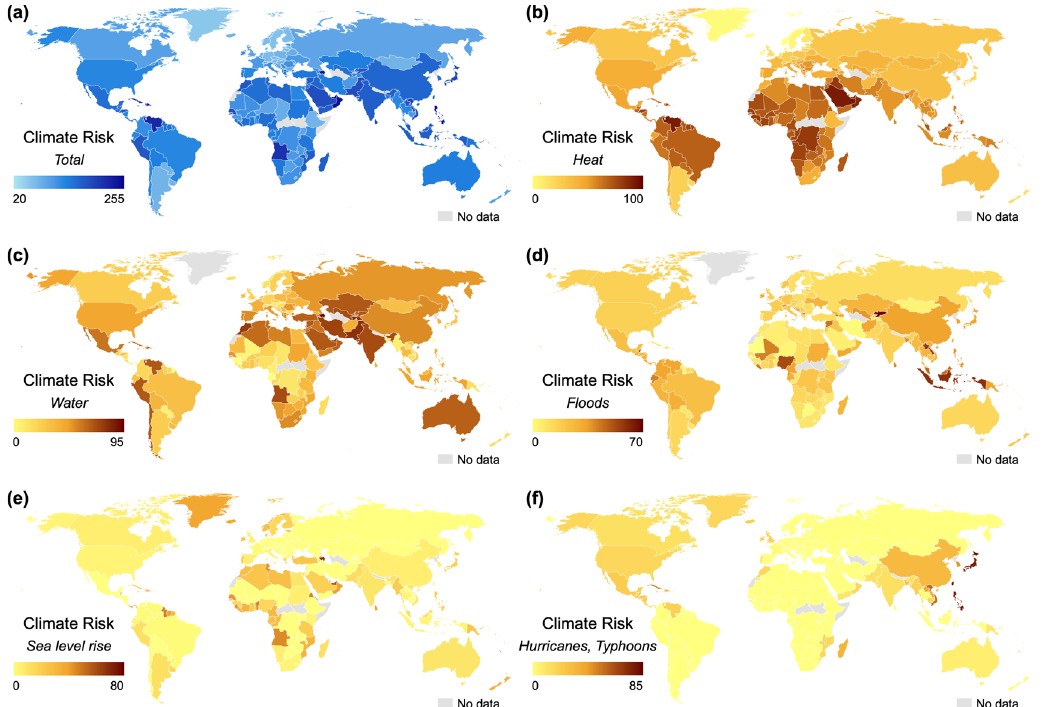
Fig. 3 Average climate risk scores of overseas facilities by host country. Analysis based on climate risk scores and facility statistics of 2233 public companies from Four Twenty Seven. The map images are created by the authors using ArcGIS. ( a ) Aggregate climate risk score, ( b ) heat stress score, ( c ) water stress score, ( d ) fl oods score, ( e ) sea level rise score, ( f ) hurricanes/typhoons score.